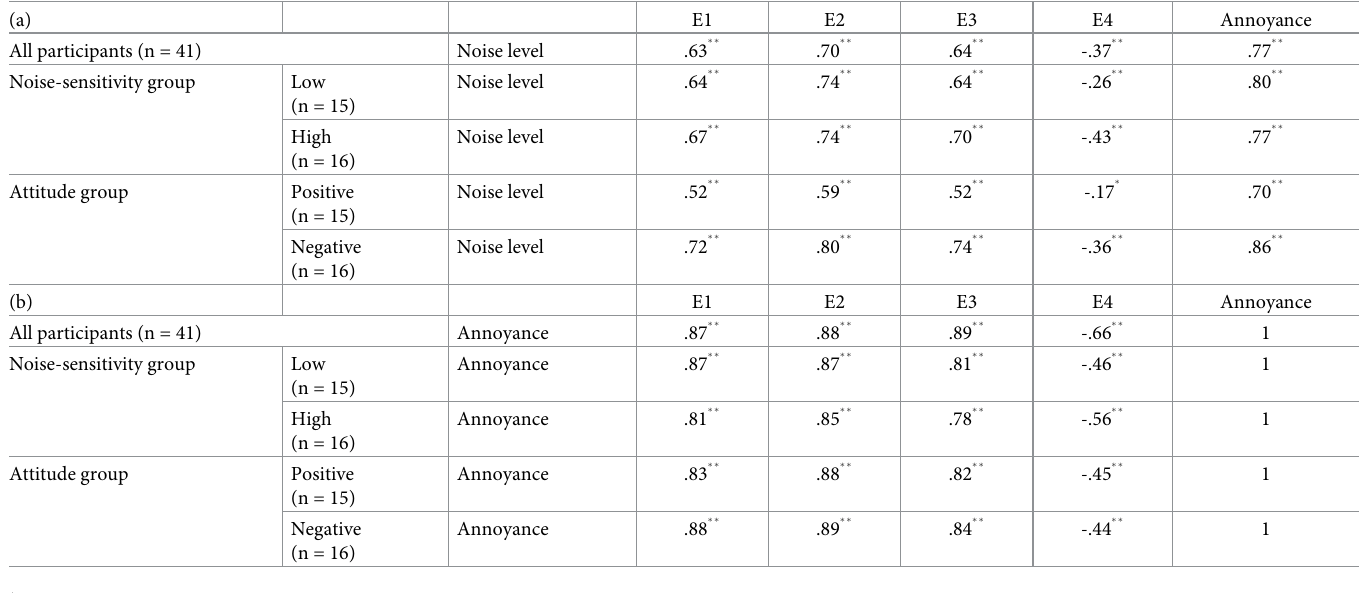
Table 8. Correlations of emotions (E1–E4) and noise annoyance with (a) noise level and (b) annoyance; tested between all participants, noise-sensitivity groups, and atti- tude